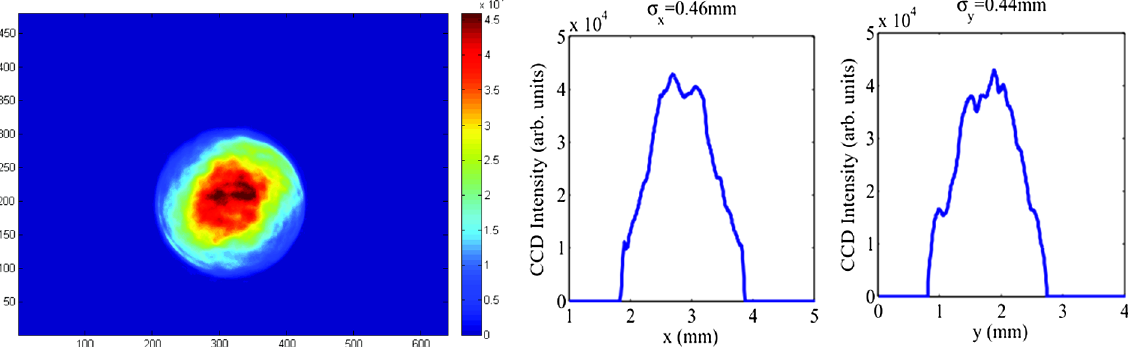
FIG. 18. Laser profile in the high-power operation (left), and the laser profile measured during high power operation